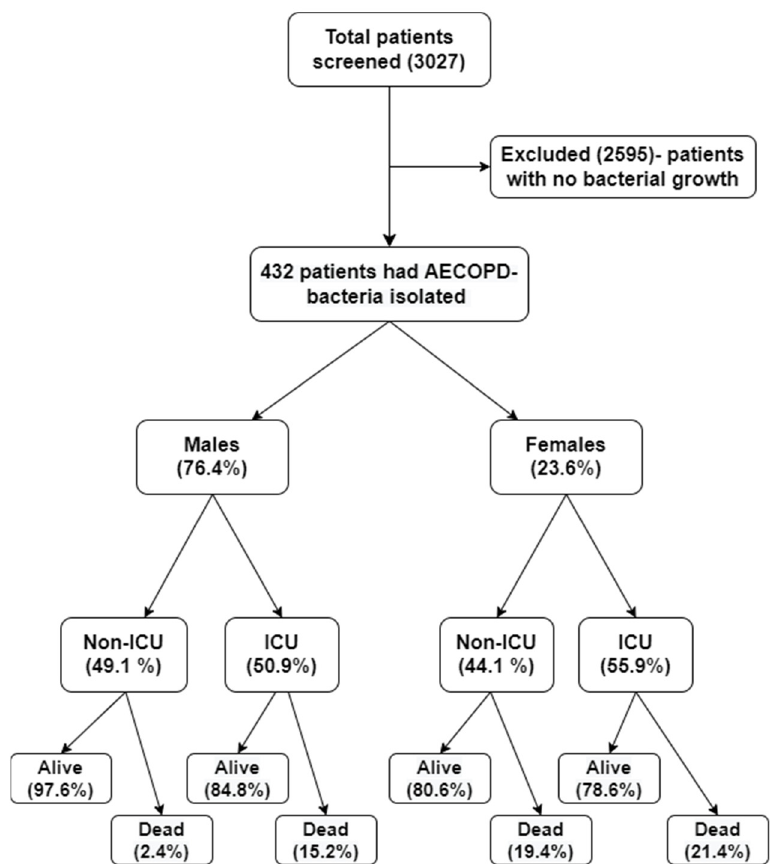
Figure 1. Flowchart of the study identifying the total number of subjects screened, number of subjects in whom bacteria have been isolated, their gender distribution, their place of admission (ICU or non-ICU), and the rates of in-hospital mortality. Table 1. Describes the clinical, demographic, microbiologic characteristics, survival of the study subjects, and the test of significance between the male and female subjects with AECOPD.